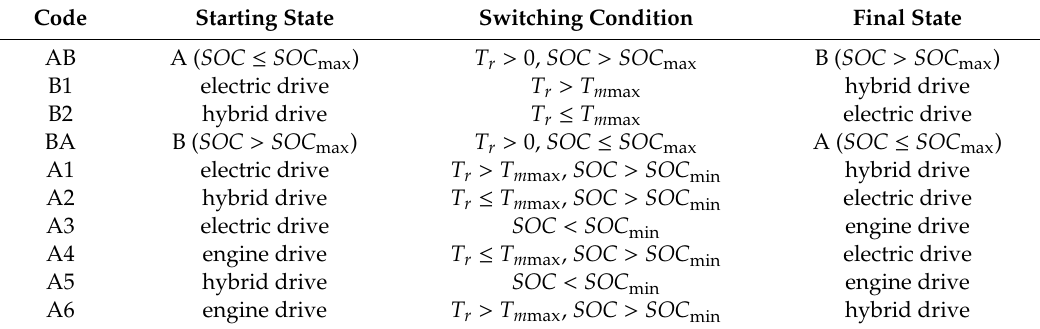
Table 3. The operating state and switching conditions of the rule-based control strategy without the torque coordination.